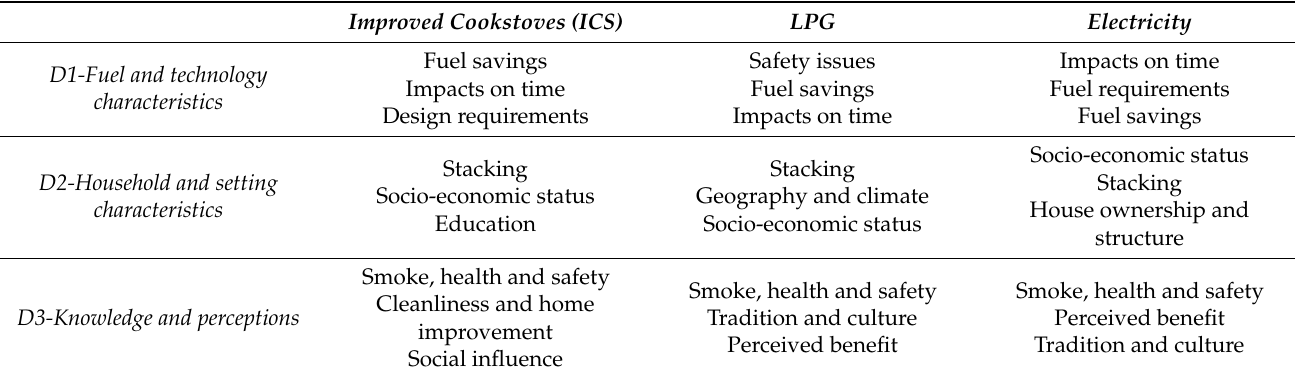
Table 4. Comparison of factors influencing the uptake of ICS, LPG and electricity showing the three most important factors in each domain, identified by the number of studies mentioning each